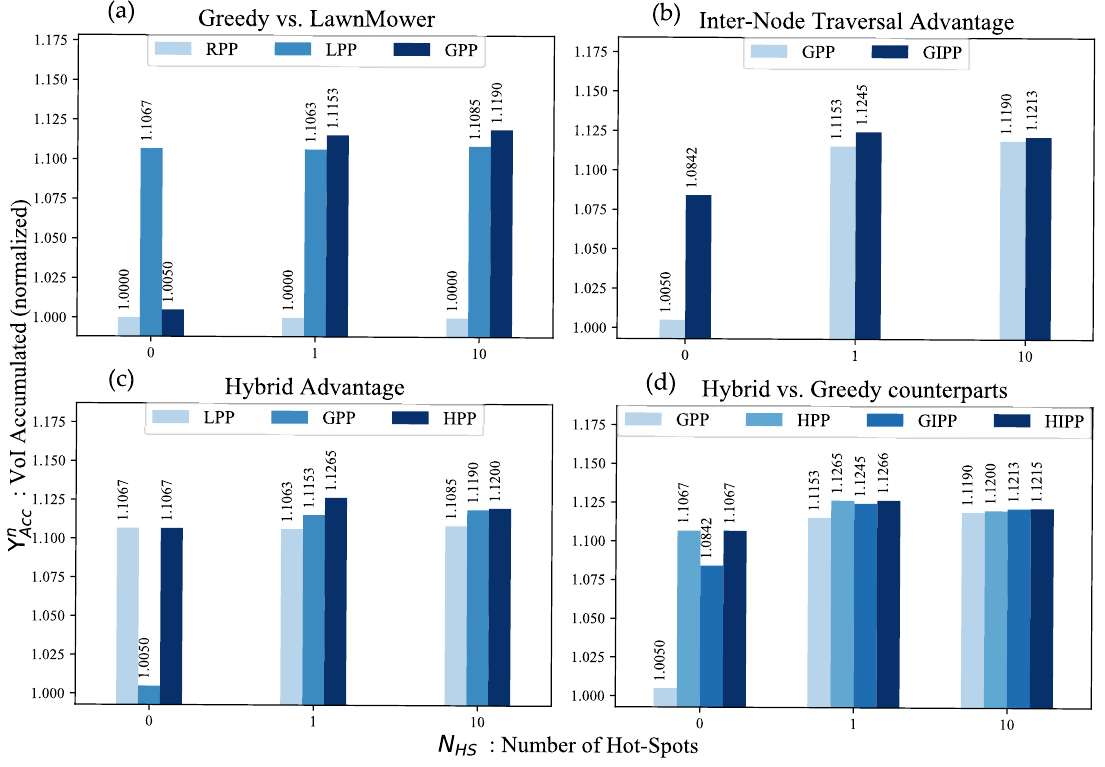
Figure 4. Bar graphs for justifying the use of various heuristics: ( a ) Greedy vs. Lawn-Mower; ( b ) Inter-Node Traversal Advantage; ( c ) Hybrid Advantage; ( d ) Hybrid vs. Greedy